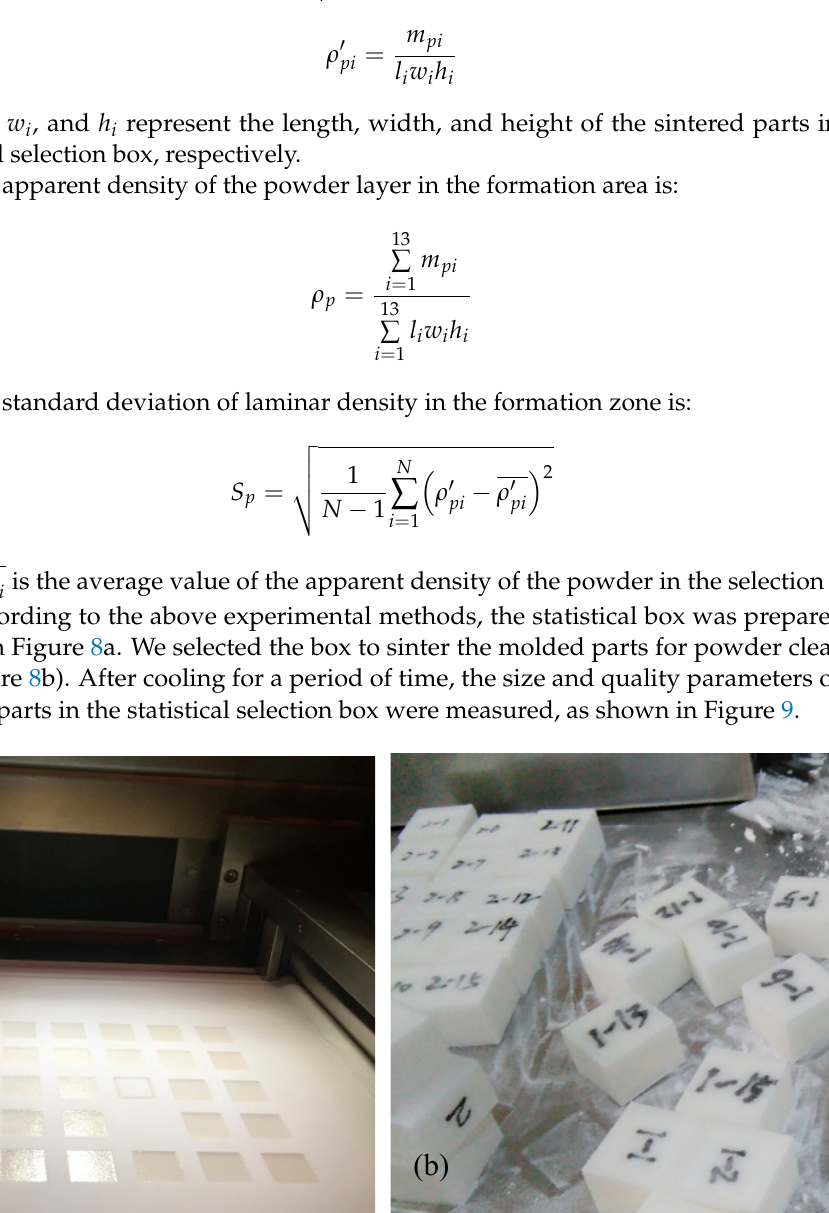
Figure 9. The size and quality parameters of sintered parts in the selection box. With the increase in drum speed, the apparent density of the powder in the formation area decreases (Figure 10). The reliability of the numerical simulation study on SLS powder laying process of nylon powder was verified. When the PA3200 powder D50 is 50 μ m, the diameter of powder spreading drum is 40 mm, the ratio of the linear velocity to translation velocity of the drum is 0.5, the translation velocity of drum is 100 mm/s, the apparent powder density in the formation area is 579.8 kg/m (cid:2871) (Figure 10a), and the standard deviation of the apparent powder density in the formation area is 70.3 kg/m (cid:2871) (Figure 10b). This is in good agreement with the absolute value of optimization target result no. 1 in Table 5, and the errors are 2.38% and 1.69%, respectively. When the roller translation speed is 140 mm/s, the apparent powder density in the formation area is 543.1 kg/m (cid:2871) and the standard deviation of the apparent powder density in the formation area is 66.1 kg/m (cid:2871) . This is in good agreement with the absolute value of optimization target result no. 14 in Table 5, and the errors are 2.82% and 4.59%, respectively. This shows that the experimental method of online sampling and measurement of the powder laying quality is feasible and that the multi-objective optimization results of the nylon powder laying quality in the SLS process based on the genetic algorithm are reliable.